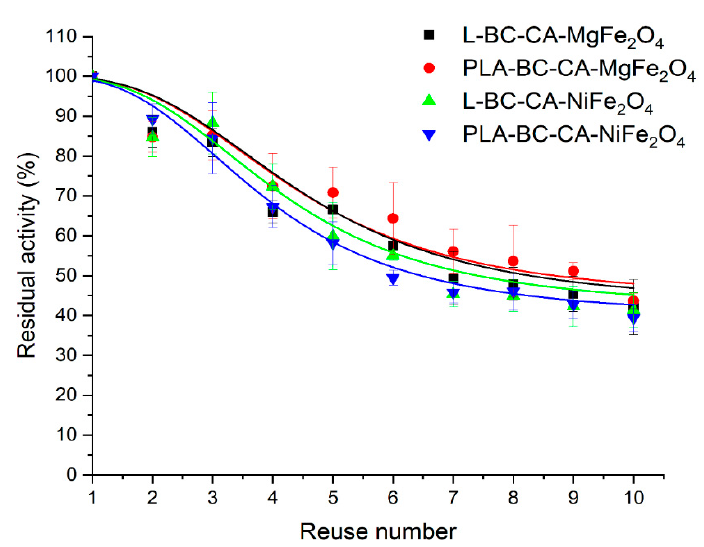
Figure 9. The reusability of PLA and lipase immobilized on different carrier variants.